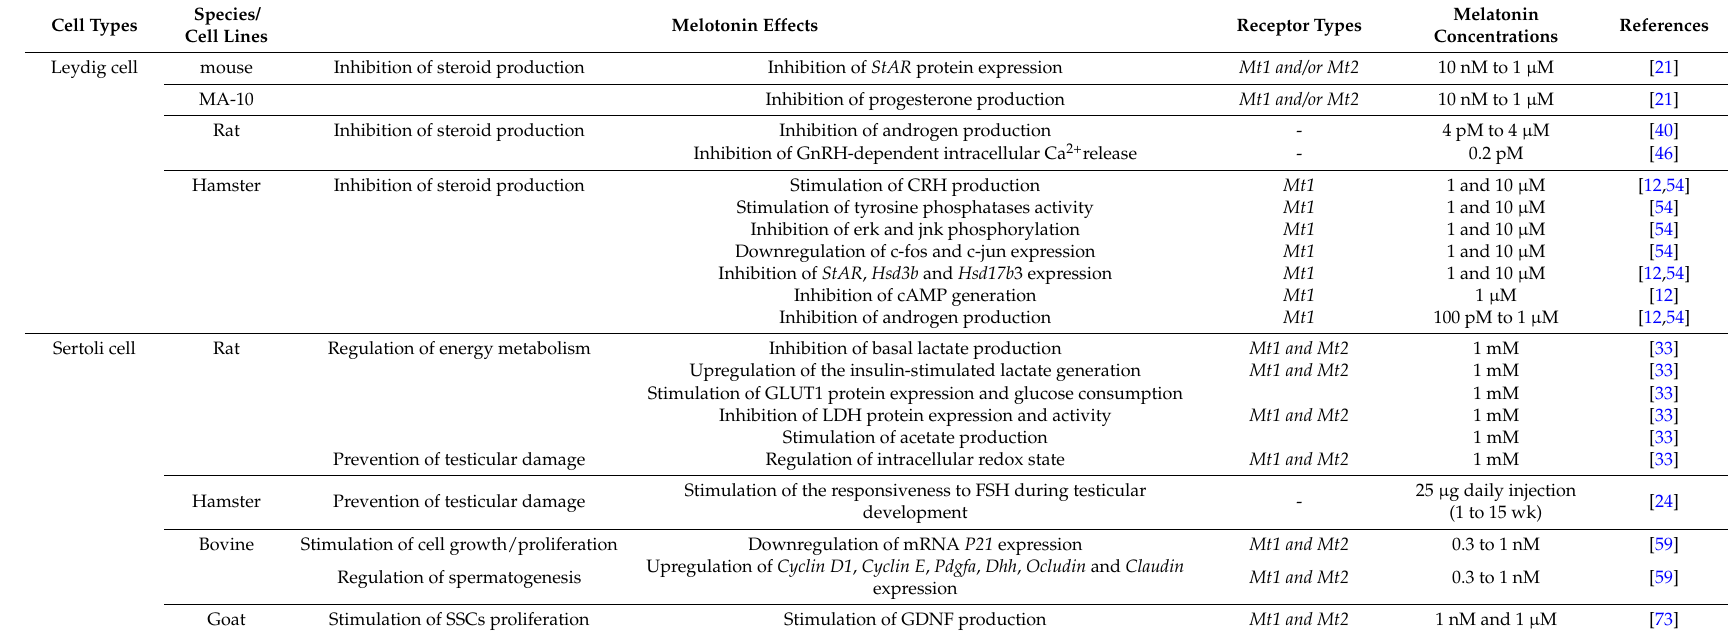
Table 1. Effects of melatonin on the key somatic cells of the testis: Leydig and Sertoli